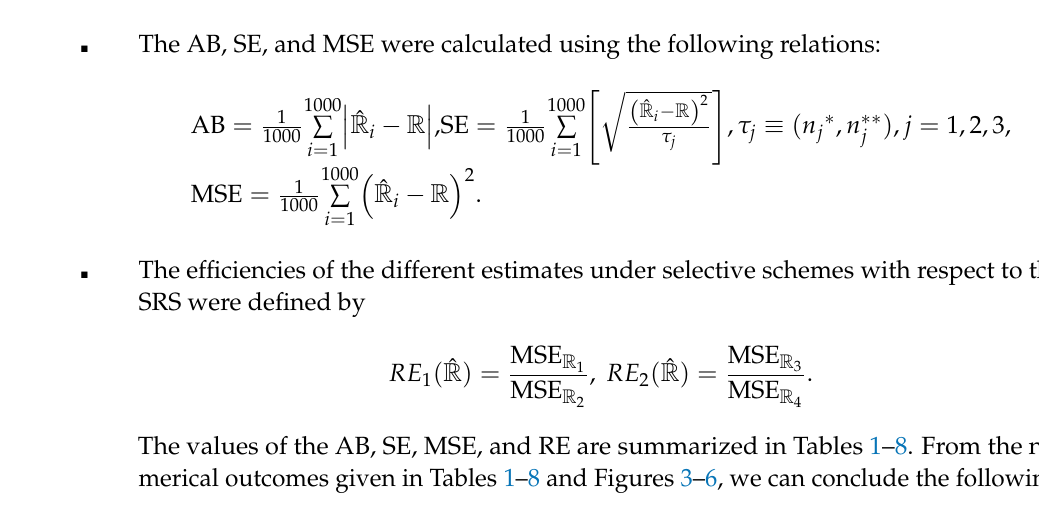
Table 1. Measurements of ˆ R 1 and ˆ R 2 for sampling schemes at R = 0.9 and d = 5.